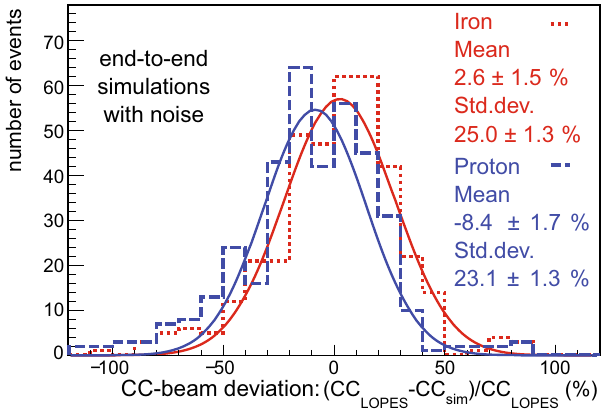
Fig. 11 Comparison of LOPES measurements and end-to-end sim- ulations including noise for the cross-correlation amplitude (i.e., the histograms to Fig. 10) and the amplitude (cid:4) 100 at 100m distance from